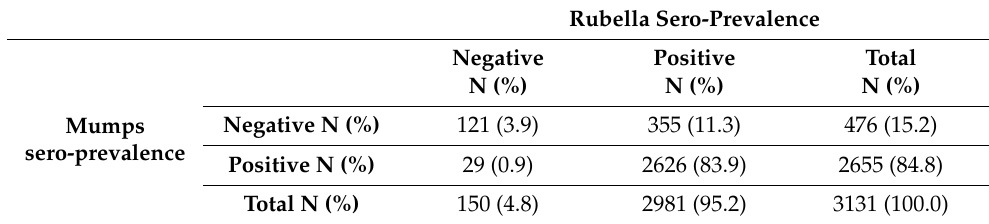
Table 5. Concordance between the sero-prevalence of mumps and